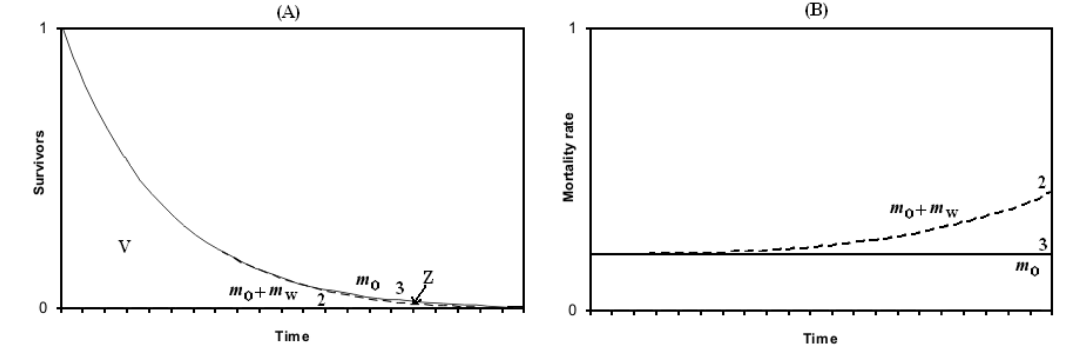
FIGURE 2. Non-IMICAW condition. (A) Life table in the wild of a non-IMICAW species, determined by m 0 + m w (Curve 2); hypothetical life table with the action of m 0 (Curve 3) only; V is the area delimited by Curve 2; Z is the area between Curves